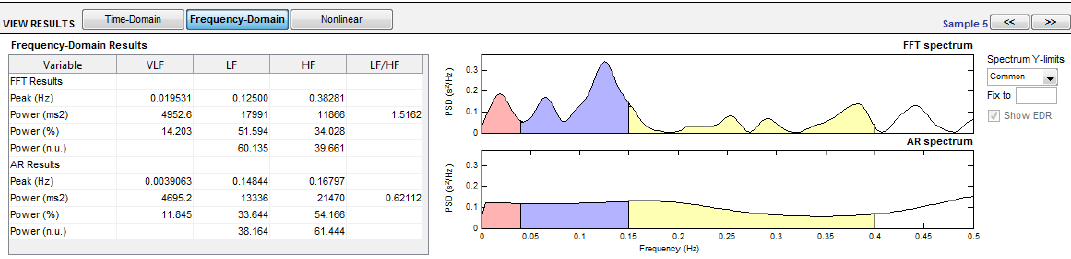
Figure 7. Example of the information obtained with the use of the Kubios software (University of Kuopio, Kuopio, Finland) for heart rate variability (HRV) analysis [36,37].